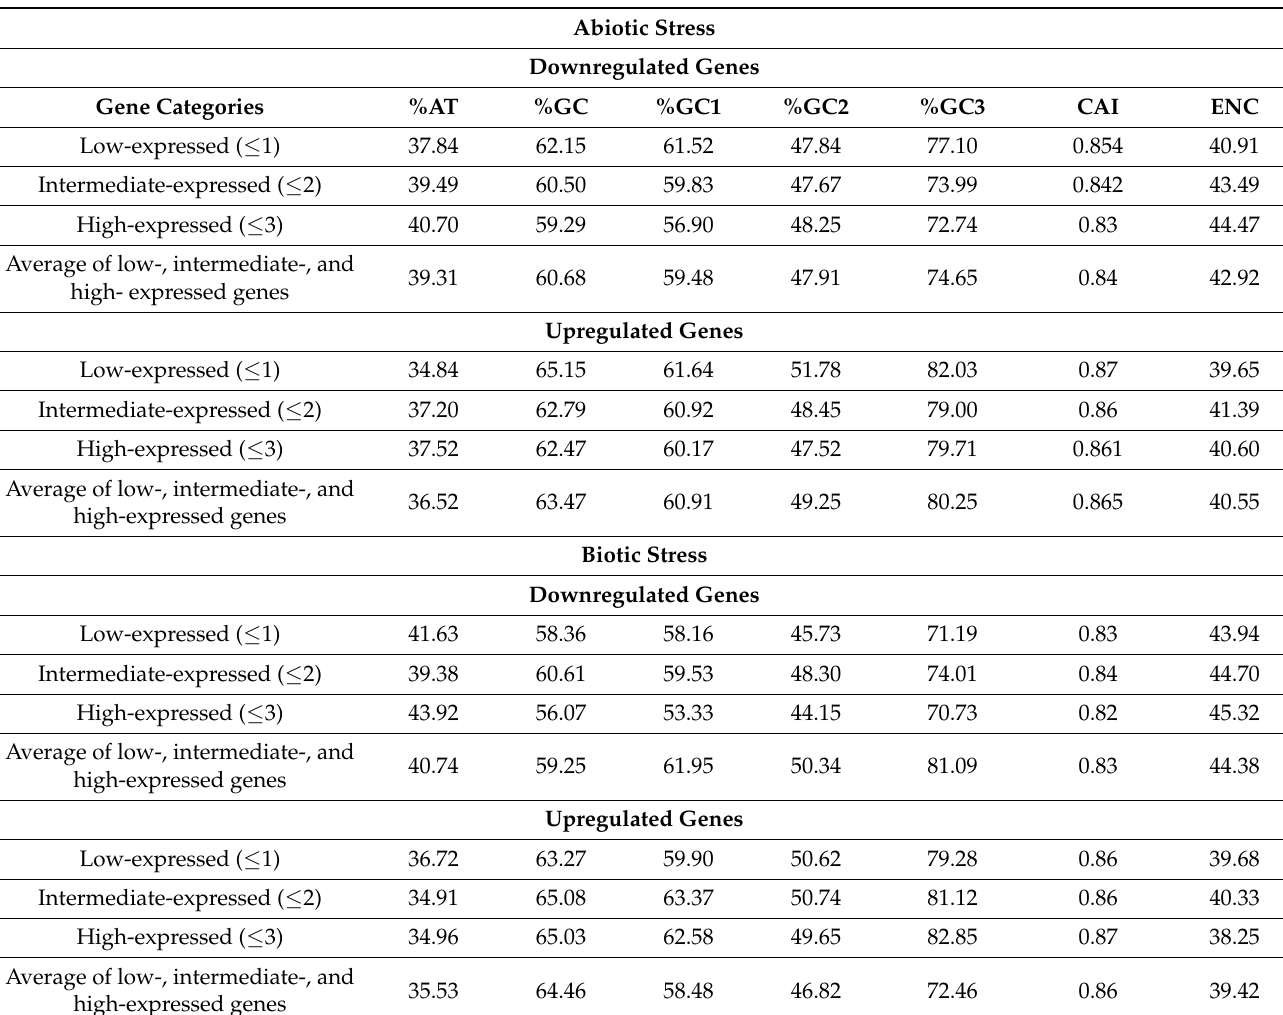
Table 1. Average %GC, %GC1, %GC2, %GC, CAI, and ENC of upregulated and downregulated genes under abiotic and biotic stress